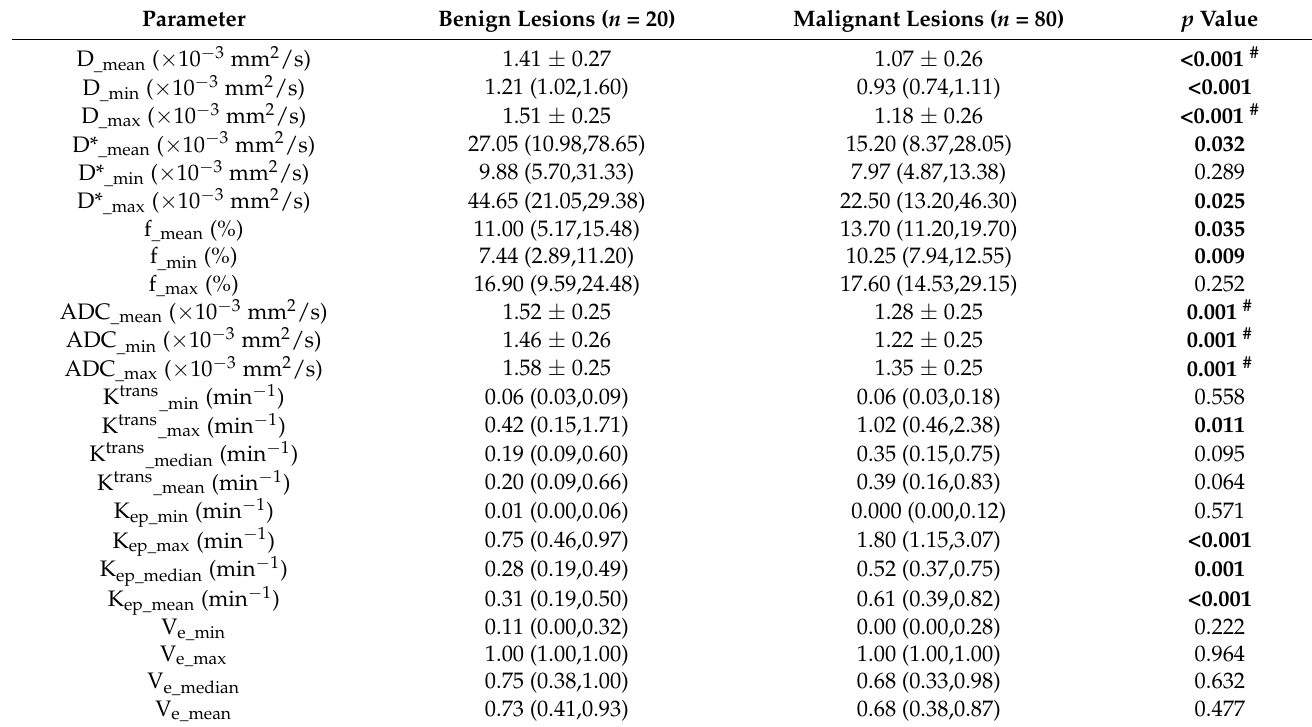
Table 3. Comparison of parameters between benign and malignant lesions.